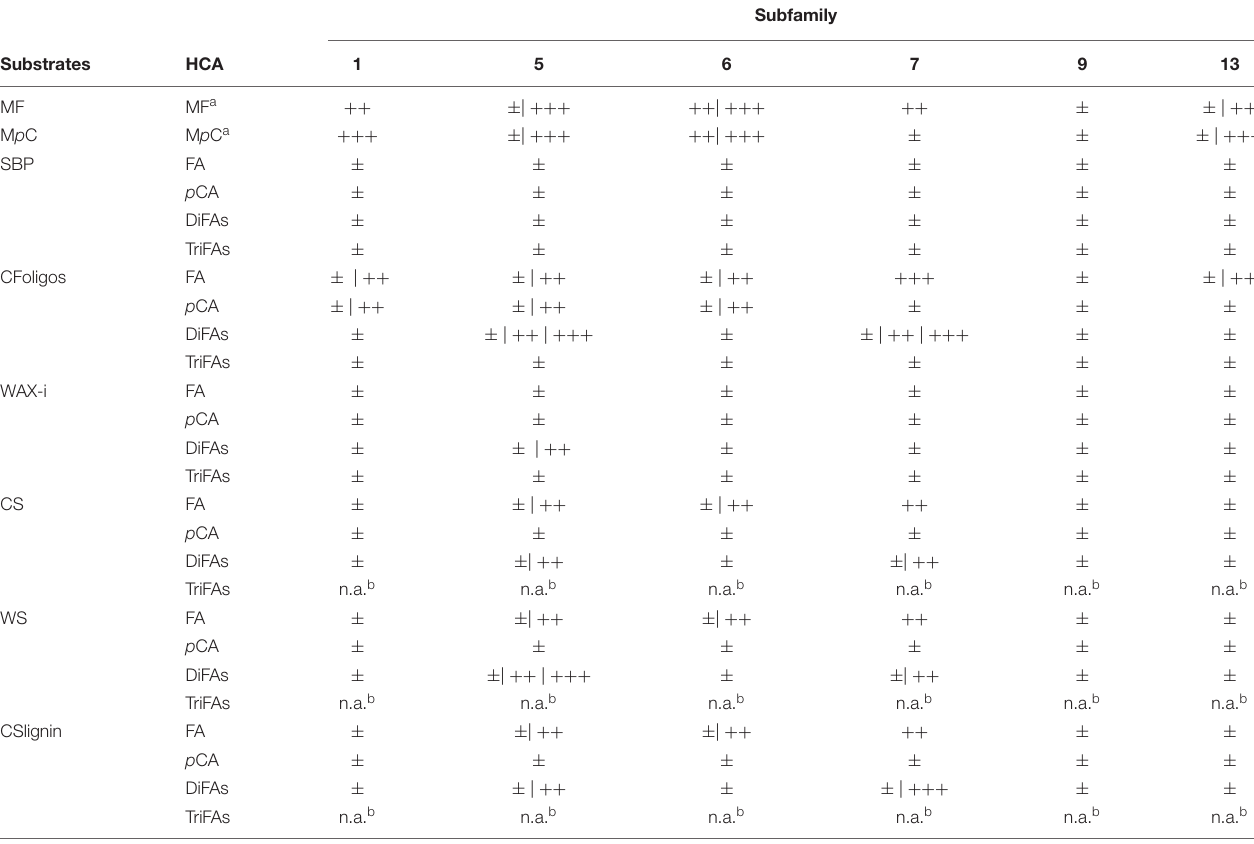
The symbols represent percentages which are calculated based on the release of HCAs (FA, pCA, diFAs and triFAs) from substrates incubated with FAEs of one SF compared to the total amount of ester bond HCAs that have been determined by saponification of the substrates. The type of HCA and the ratio within these compounds released varied for different FAEs of one SF ( Figures 4–6 ), which leads to the occurrence of more than one symbol. The substrate specificity is shown as low (“ ± ”; 0–20%), medium (“ ++ ”; 20–80%) and/or high (“ +++ ”; 20–80%) values. a Results represent the incubation of MF and MpC with FAEs for 19 h ( Figure 4 ). b No release of TriFA was determined from the incubation of these substrates with